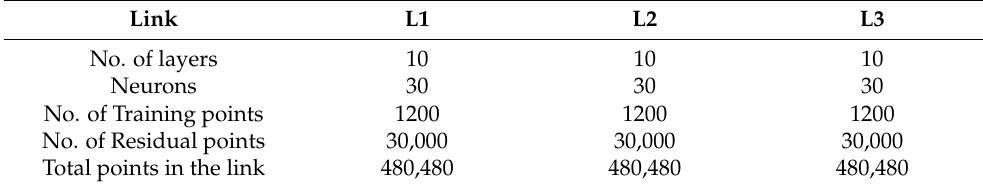
Table 4. PINNs architecture and summary of data points in each link of the